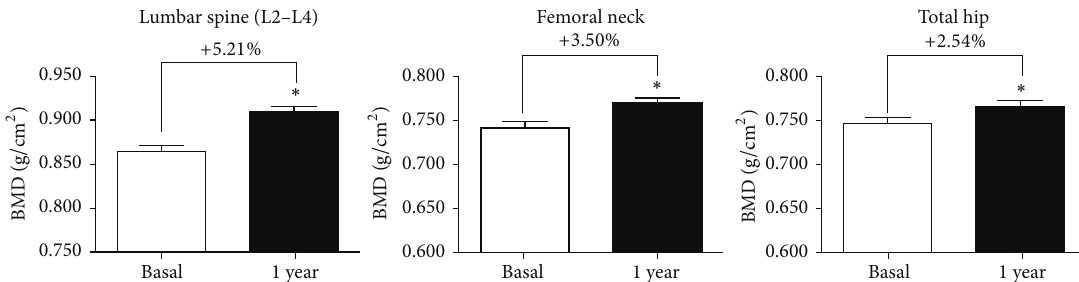
Figure 1: Change in BMD after 1 year of treatment with Dmab. ∗ indicates significant differences from basal ( 𝑝 < 0.0001 ).